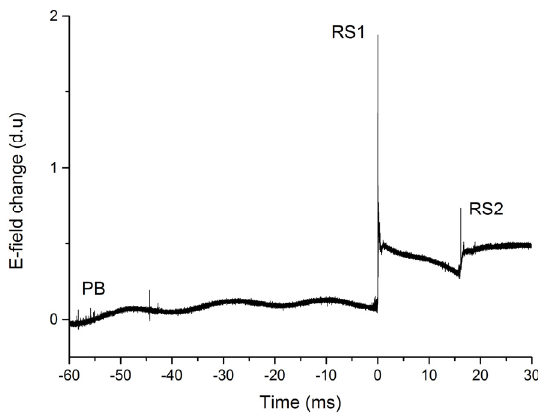
Figure 2. Typical multiple strokes of positive cloud to ground (CG) electric field waveform. Table 2. Comparison of positive CG multiple strokes.